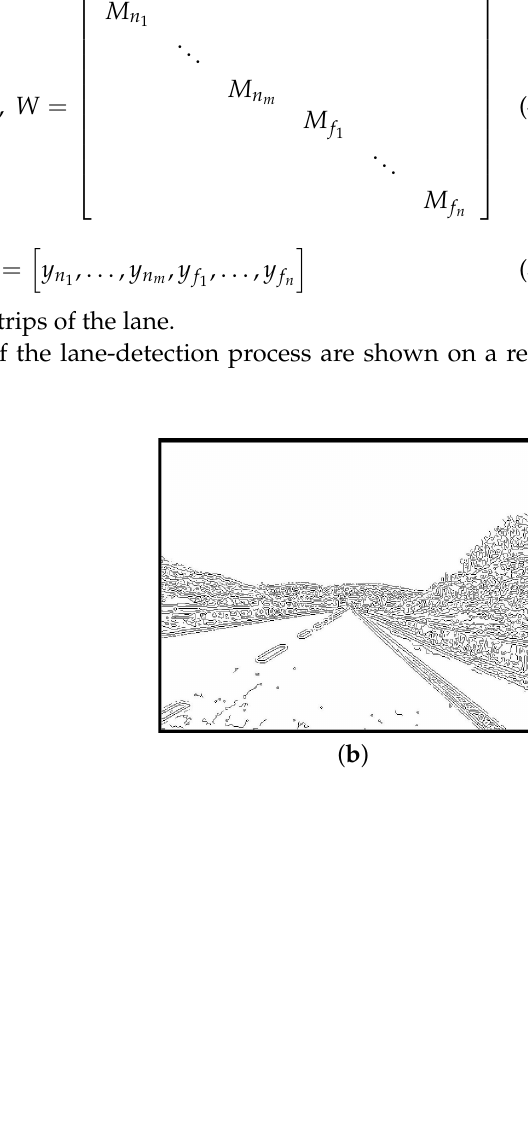
Figure 6. Lane detection: image acquisition and preprocessing ( a ), edge extraction ( b ), and line identification ( c